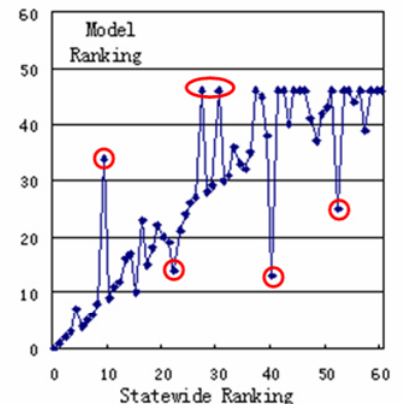
Fig.4. Model Evaluation for Type-322